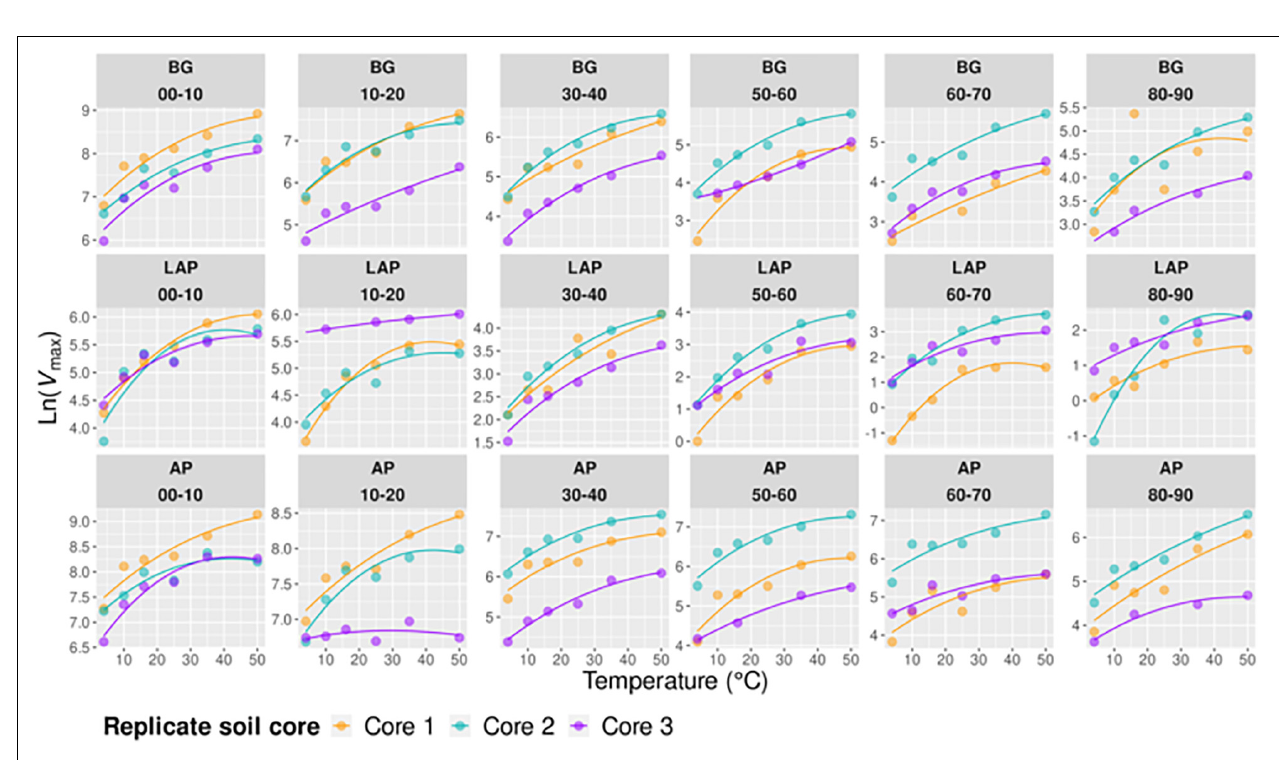
FIGURE 6 | Macromolecular Rate Theory (MMRT) models of V max over six temperatures from 4 to 50 ◦ C per enzyme, depth, and replicate core sample.